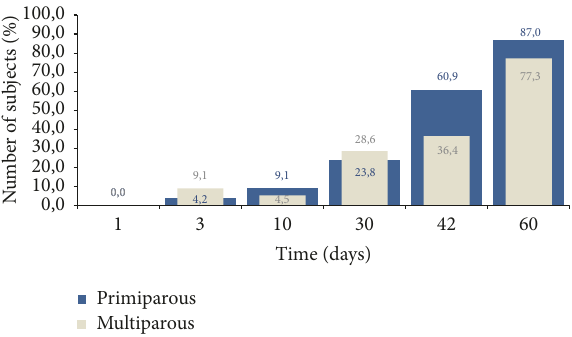
Figure 14: Diastolic notch appearance during